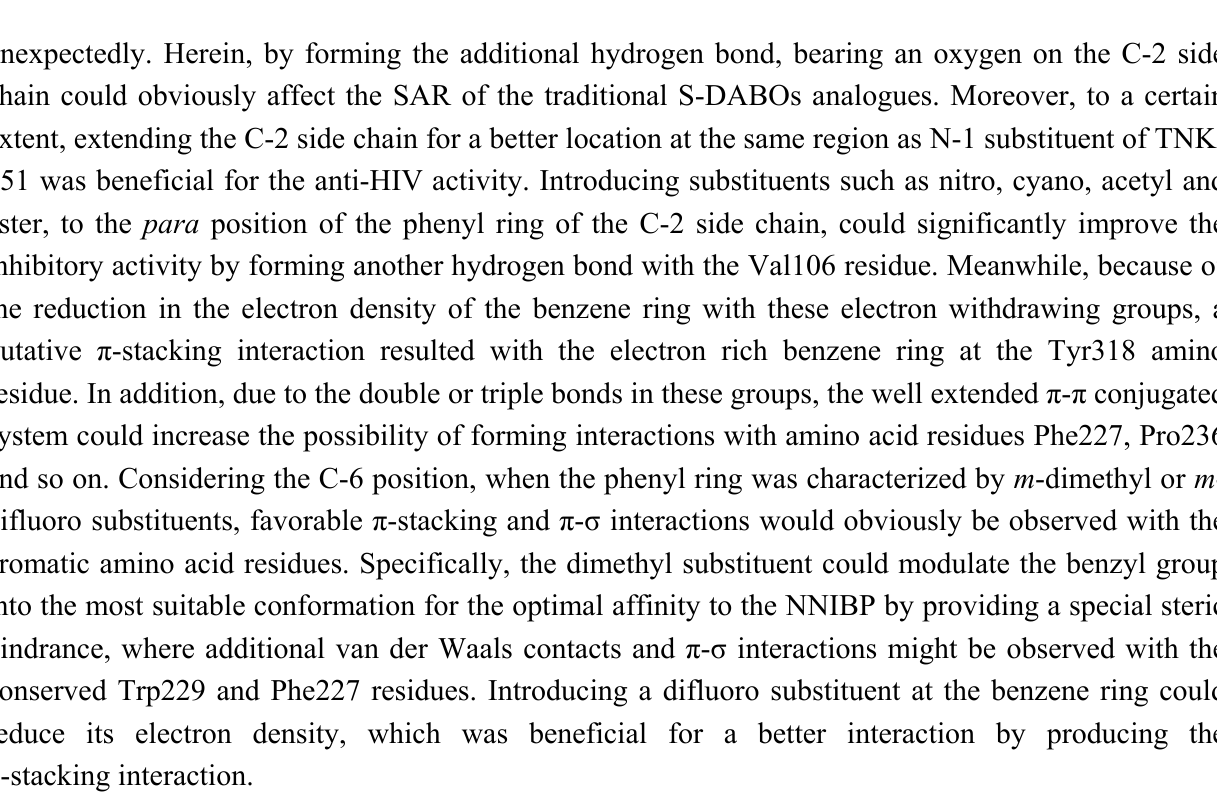
Figure 3. Binding mode of 8n ( a ), 8q ( b ) (blue) and TNK-651 (green) with HIV-1 RT. Hydrogen bonds are shown as a green dashed lines, and halogen bonds are shown as a green solid